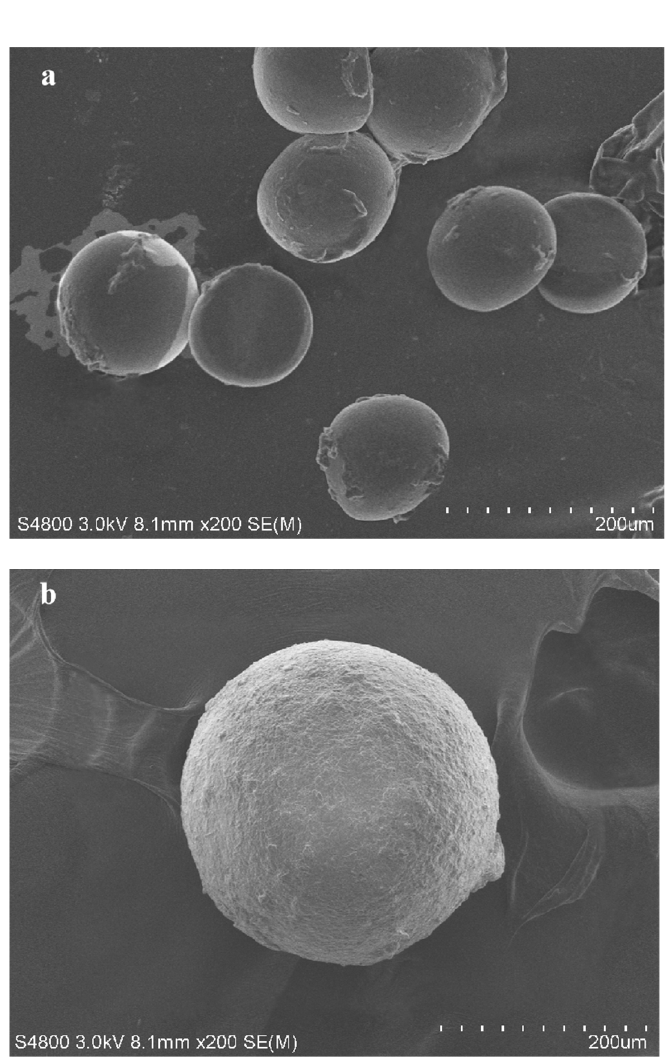
Figure 6. SEM image of microcapsules. ( a ) SWMs, ( b )